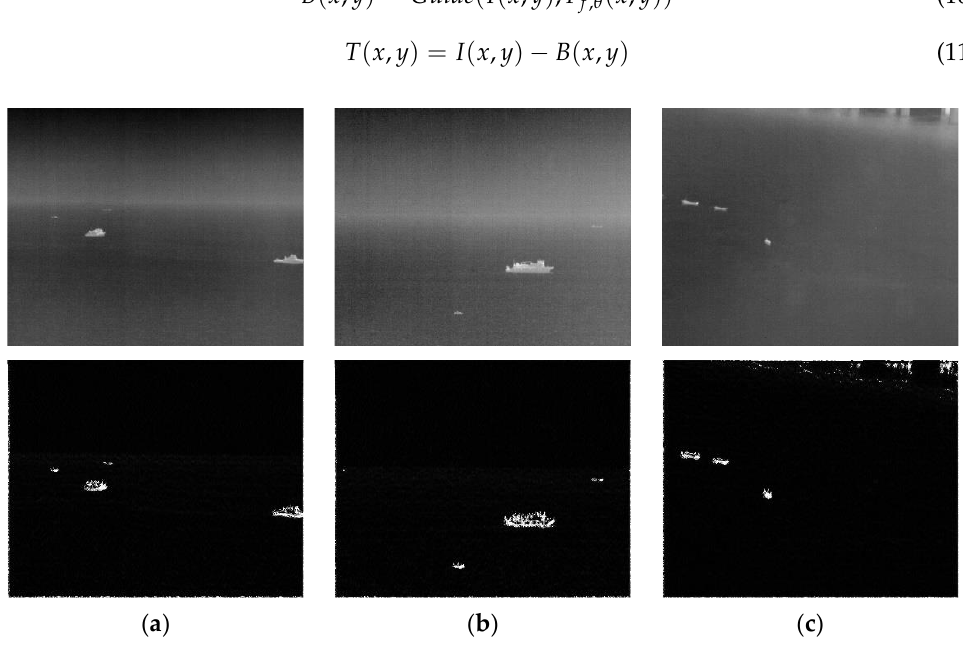
Figure 10. Original image of the calm sea surface and its target feature image. The upper part of ( a – c ) is the original image, and the lower part is the target feature image of each image.